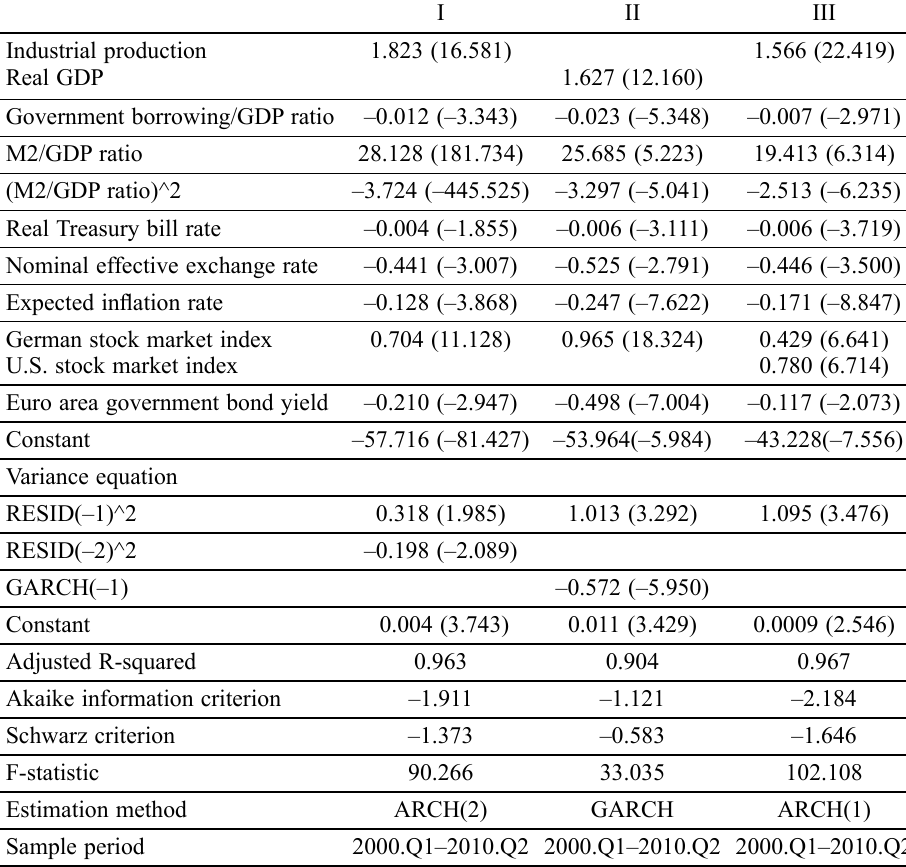
Fig. 1. The stock market index in Poland: 2007.M1–2009.M12 Table 1. Estimated regressions of Poland’s stock market